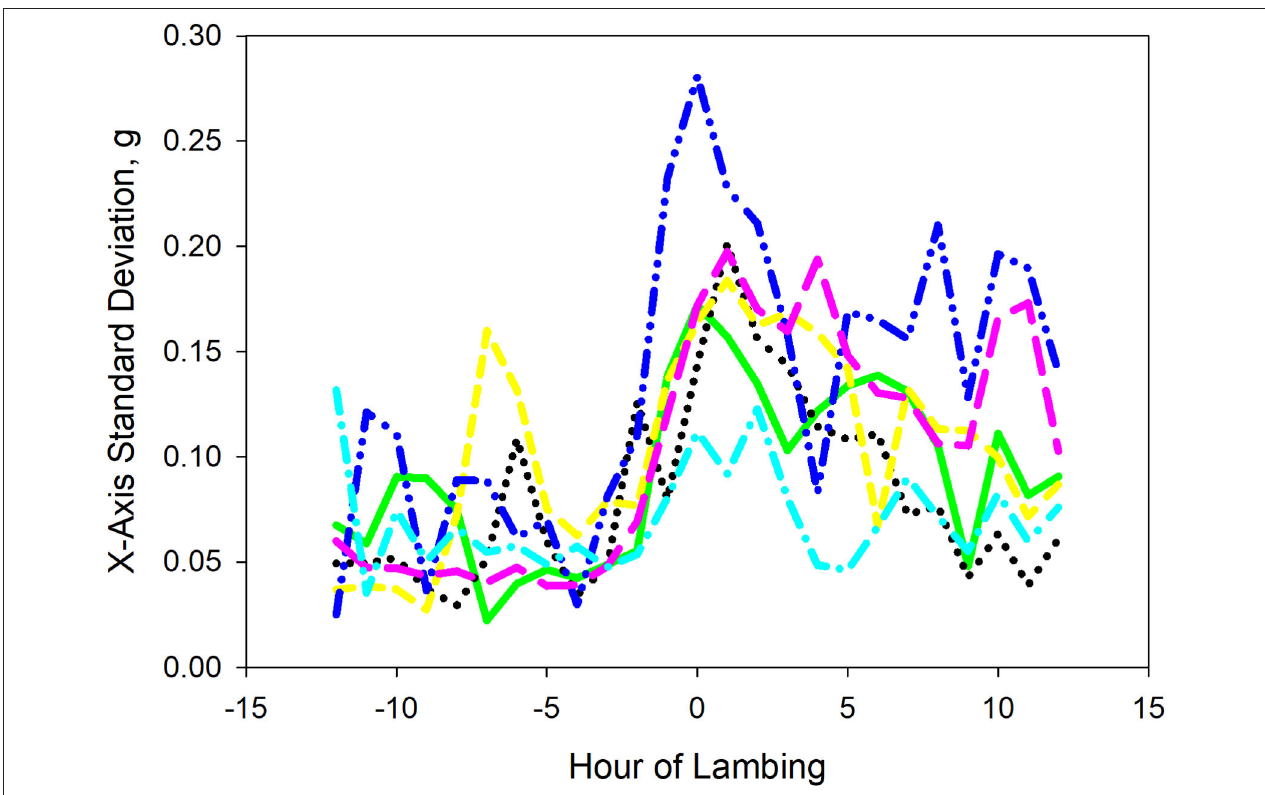
FIGURE 1 | Variability among ewes for an accelerometer-based metric, standard deviation of the x -axis (side to side head movements), during the 12h before and after lambing. Different line types and colors represent the six ewes in the study. Note: the variation in the x -axis were relatively low 3–4h prior to lambing (hour 0), and the variation rises for the period 2h preceding and 2h following lambing. However the magnitude of variation differs among ewes.